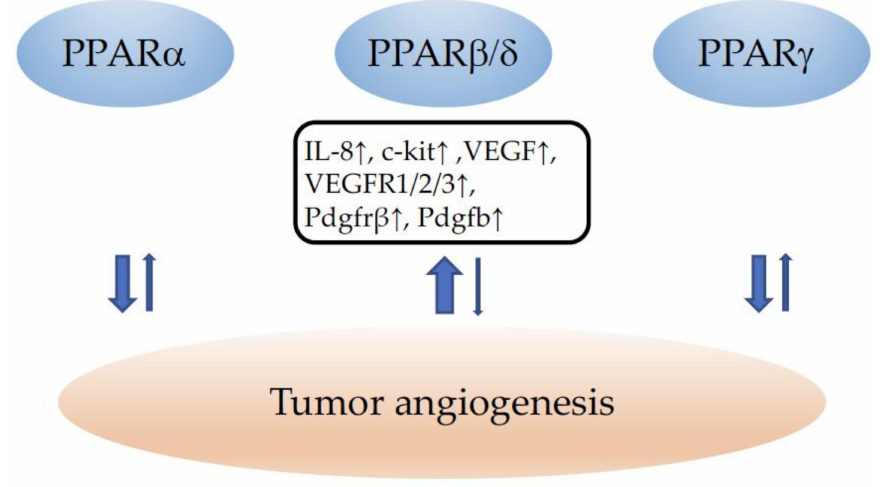
Figure 3. Summary of the influence of PPAR α , PPAR β / δ , and PPAR γ on tumor angiogenesis. ↓ indicates inhibition and ↑ an increase in angiogenesis. The width of the arrows corresponds to the number of studies reporting similar effects. IL-8: interleukin-8; c-kit: tyrosine-protein kinase Kit; VEGF: vascular endothelial growth factor; VEGFR1/2/3: vascular endothelial growth factor receptors 1/2/3; Pdgfr β : platelet-derived growth factor receptor beta; Pdgfb: platelet-derived growth factor